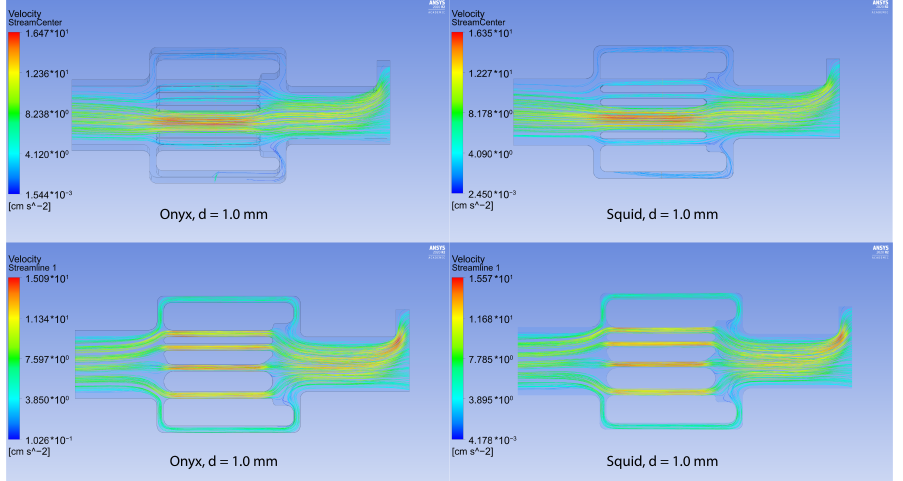
Figure 13. Velocity streamlines for the configurations with Onyx (cid:114) ( left column ) and Squid (cid:114) ( right column ) with fistula ( above ) and without it ( below ). Table 1. Pressure and WSS results of numerical calculations in the configuration with and without